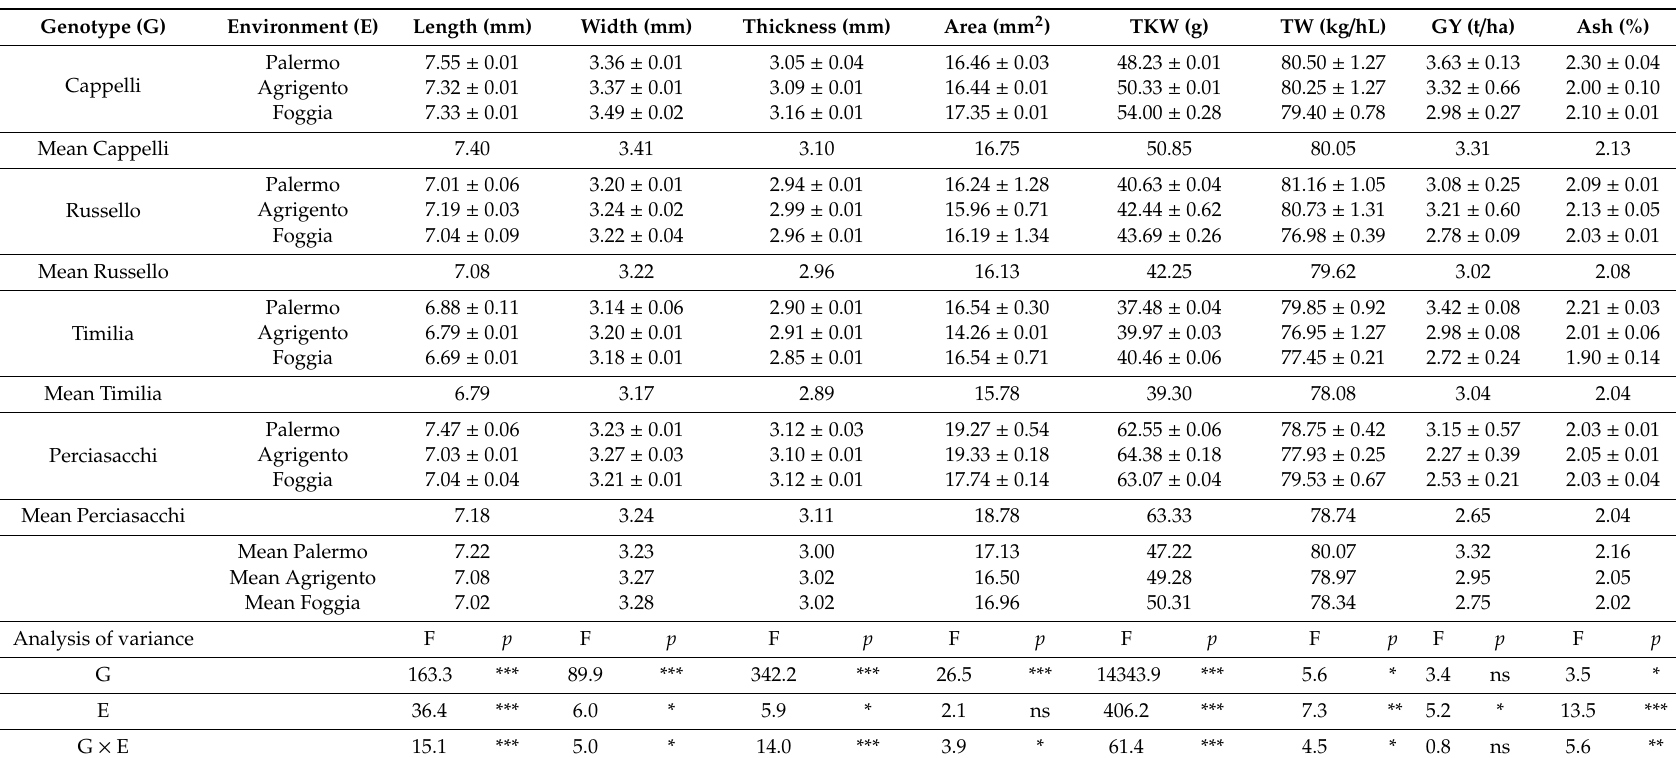
Table 1. Morphological by Image analysis and yield traits on durum wheat grains, and ash on wholemeal recorded in three